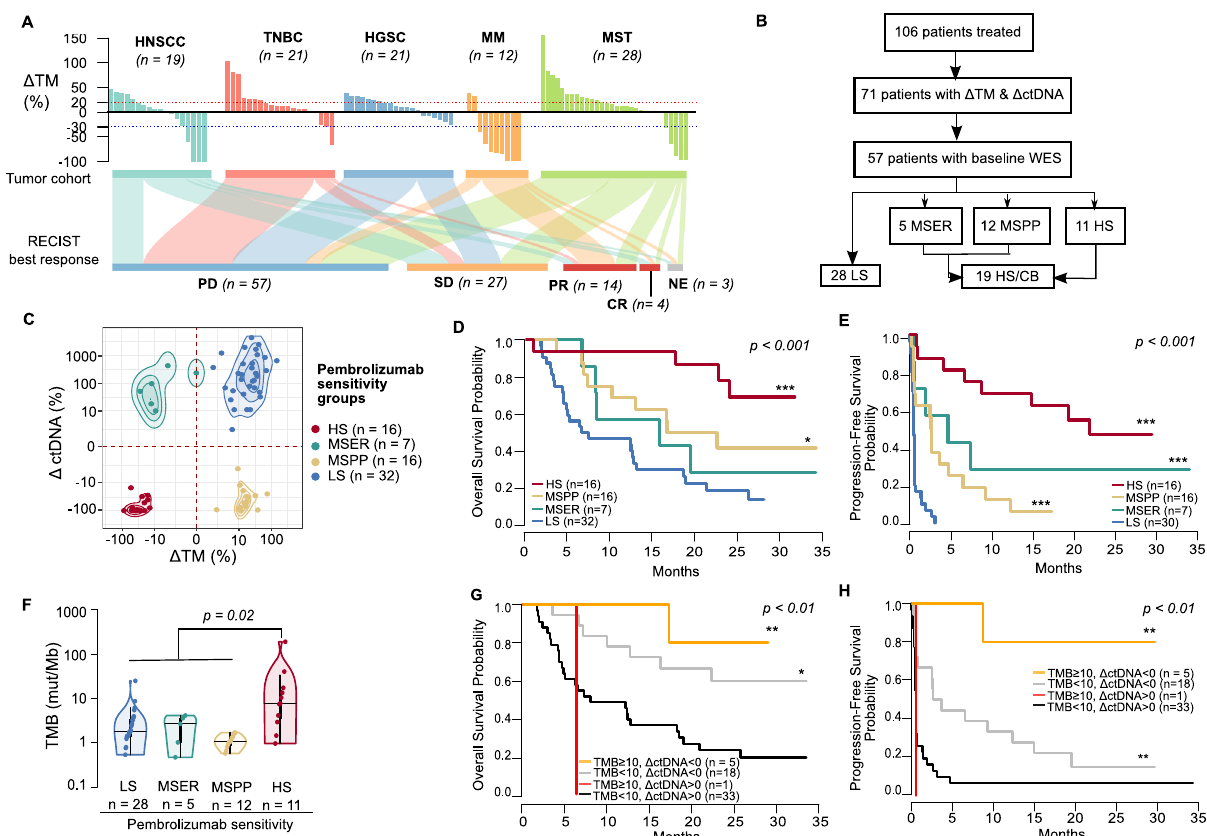
Fig. 1 INSPIRE patient strati fi cation by early Δ ctDNA and Δ TM. A Overview of change of tumor measurement ( Δ TM) at best response of all patients enrolled in the INSPIRE clinical trial ( n = 106). Patients are grouped by cancer cohort and sorted in order of decreasing Δ TM. Below the waterfall plot, widths of joining lines re fl ect the number of patients within the corresponding tumor cohort and best overall response by RECIST. B Simpli fi ed consort diagram summarizing the number of patients with complete Δ TM, Δ ctDNA, and baseline WES pro fi ling strati fi ed into the four pembrolizumab sensitivity groups. LS low-sensitivity, MSER mixed- sensitivity with emerging resistance, MSPP mixed-sensitivity with potential pseudoprogression, HS high-sensitivity. C Distribution of Δ TM and Δ ctDNA for each patient. Contours around each group indicate the density within each group with the median shown as the center of the contour. Points are colored according to pembrolizumab sensitivity groups. Dotted red vertical and horizontal lines indicate Δ TM = 0 and Δ ctDNA = 0. D Kaplan – Meier plot of overall survival from treatment cycle 3 in patients grouped by pembrolizumab sensitivity. ( p = 0.00025). E Kaplan – Meier plot of progression-free survival from treatment cycle 3 in patients grouped by pembrolizumab sensitivity. ( p = 8.7×10 − 11 ) F Comparison of TMB distribution between pembrolizumab sensitivity groups. The median for each group is shown as a horizontal line and data points are shown ordered by increasing value. The distance between the third-quartile (Q3) and fi rst-quartile (Q1), known as the interquartile range (IQR), is marked around the median by a black rectangle. Vertical lines extending from the top and bottom of the rectangle show the maximum (Q3 + 1.5-times IQR) and minimum(Q1 + 1.5-times IQR). P -values shown are calculated by a two-sided Kolmogorov – Smirnov test. F Kaplan – Meier plot for overall survival from treatment cycle 3 in patients strati fi ed by TMB ≥ 10 and Δ ctDNA. ( p = 0.0042). G Kaplan – Meier plot for overall survival from treatment cycle 3 in patients strati fi ed by TMB ≥ 10 and Δ ctDNA. ( p = 0.0053). P -values for Kaplan – Meier plots re fl ect the outcomes of log-rank tests for the survival model. H Kaplan – Meier plot for progression-free survival from treatment cycle 3 in patients strati fi ed by TMB ≥ 10 and Δ ctDNA. ( p = 0.00018). P -values for Kaplan – Meier plots re fl ect the outcomes of log-rank tests for the survival model. Statistical signi fi cance for all panels: *** p ≤ 0.001; ** p ≤ 0.01; * p ≤ 0.05; + p ≤ 0.10. Source data are provided in